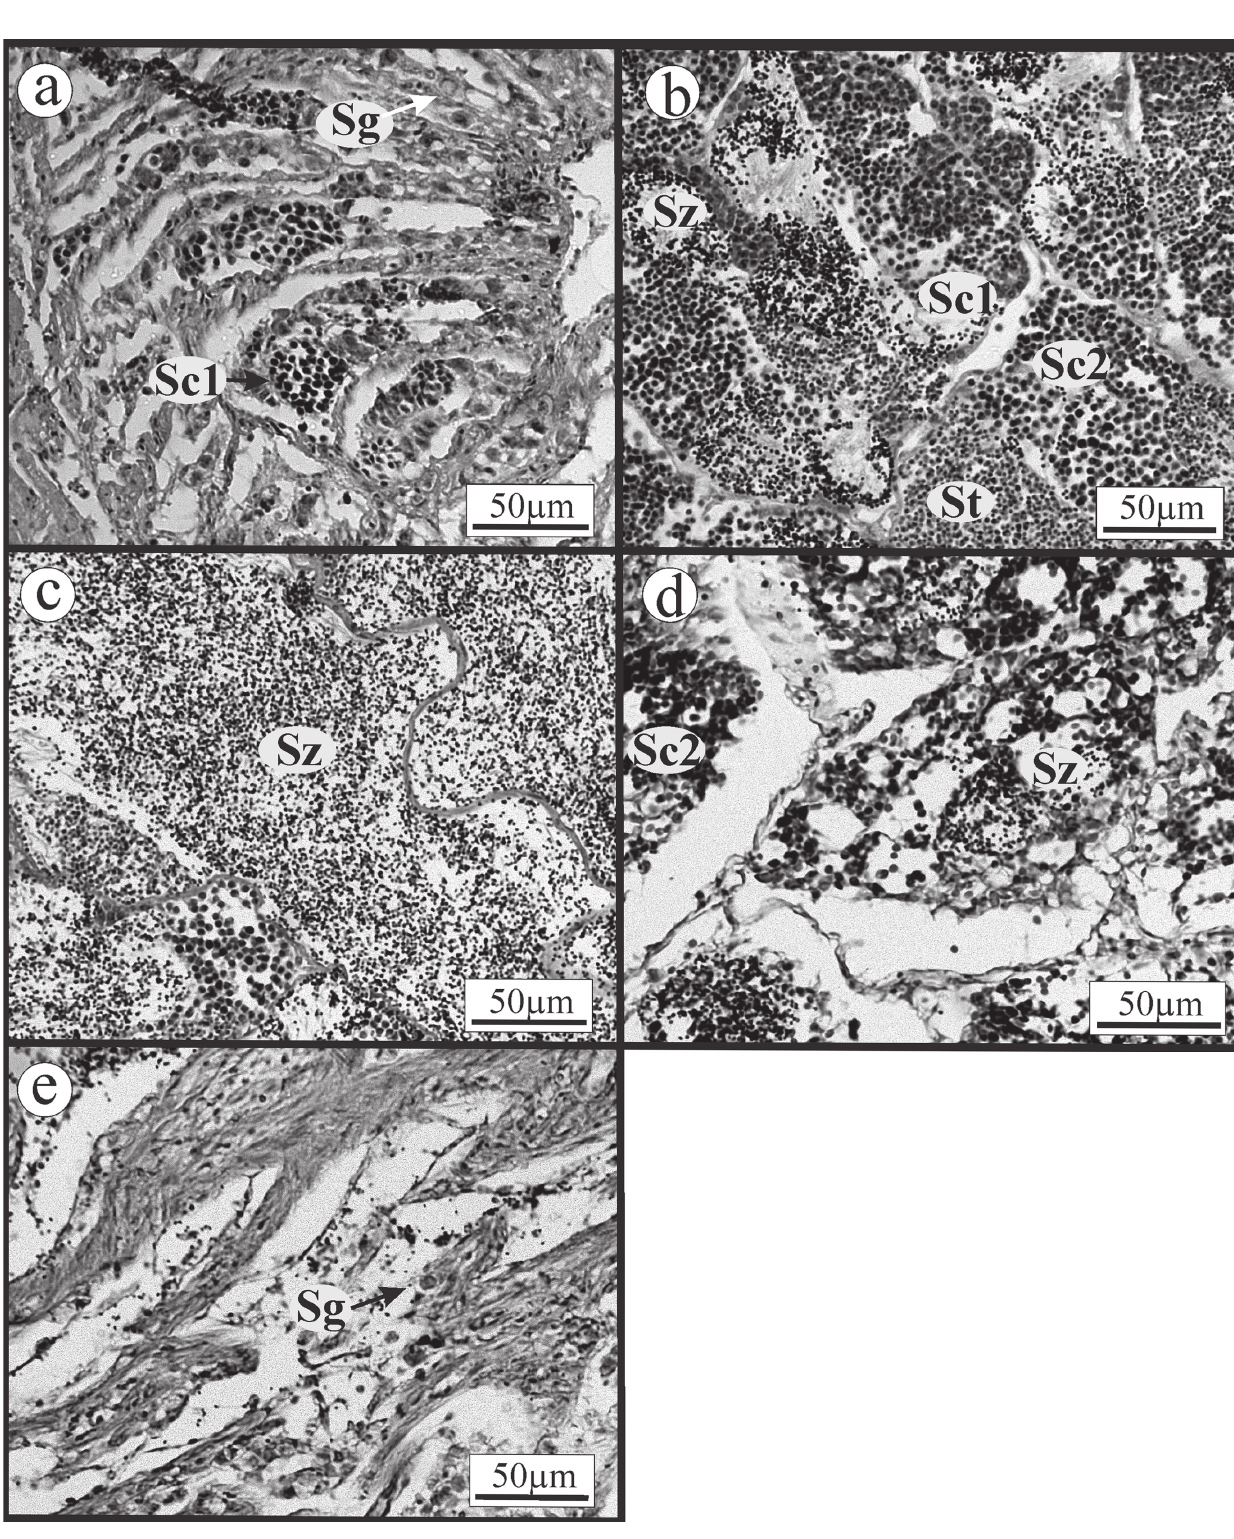
Fig. 2. Testicles of Pinguipes brasilianus in different maturation stages. a) early developing, b) developing, c) spawning capable, d) regressing, e) regenerating. Sc1: primary spermatocyte; Sc2: secondary spermatocyte; Sg: spermatogonia; St: spermatid, Sz: